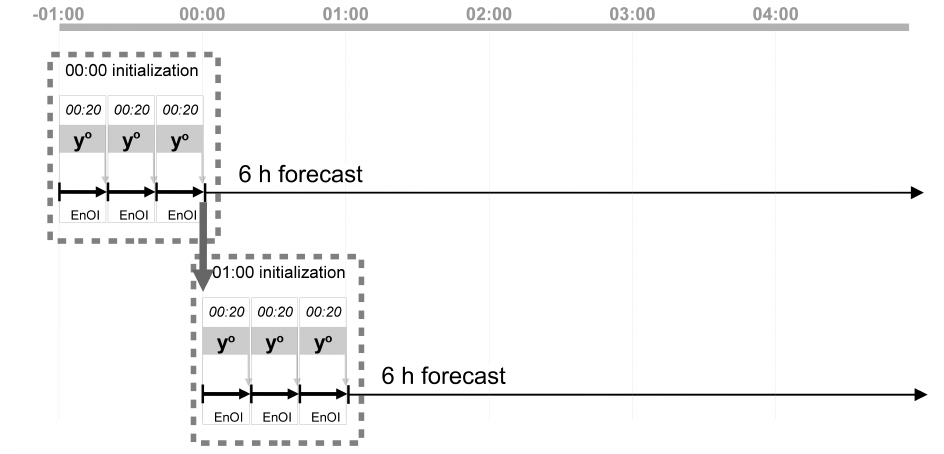
Figure 10. Data assimilation cycle in Breivik and Sætra (2001). Surface currents are used to initialize, every hour, a 6h prediction. In the initialization procedure, three cycles of EnOI are used to assimilate the current data available every 20min.